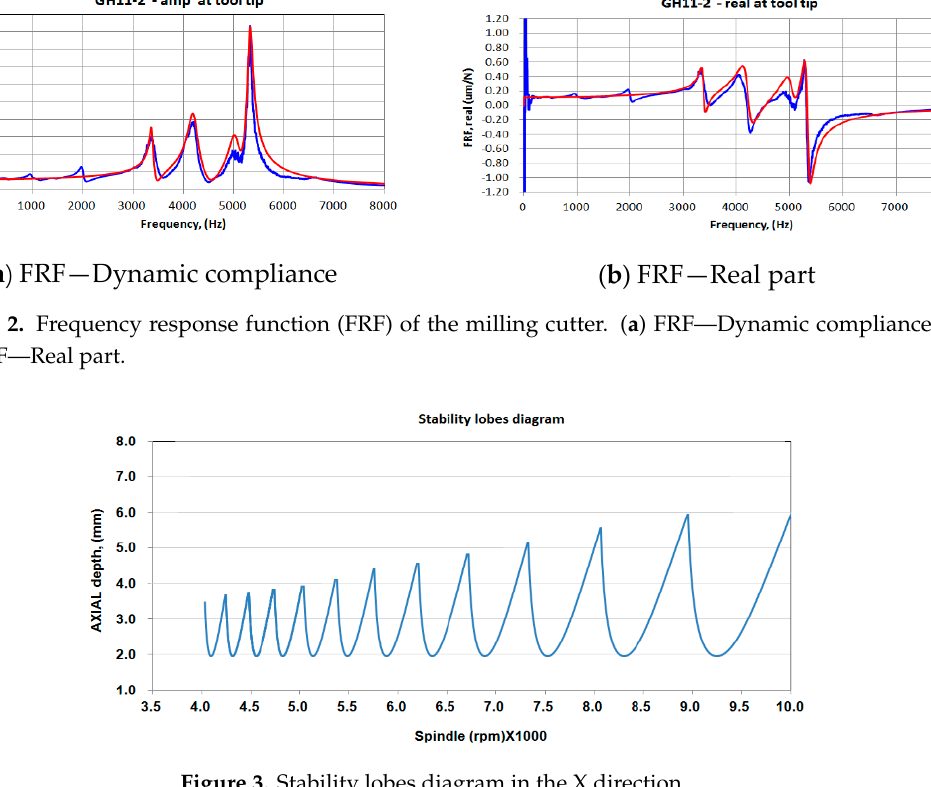
Figure 3. Stability lobes diagram in the X direction.